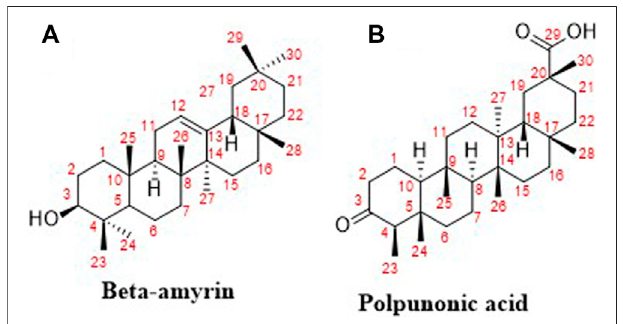
FIGURE 1 | Chemical structures of isolated compounds from Ziziphus abyssinica (Henneh et al.,